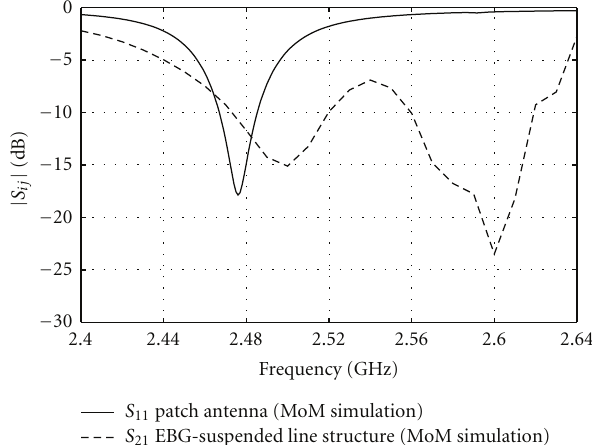
Figure 3: Schematic of suspended line above EBG surface (top view). Figure 4: Resonances to be coupled in order to achieve bandwidth